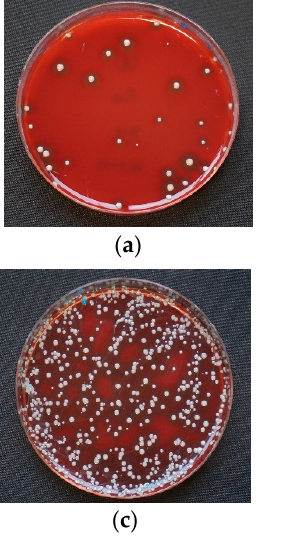
Figure 3. Examples for Staphylococcus aureus on Columbia agar at baseline after 0 min incubation.